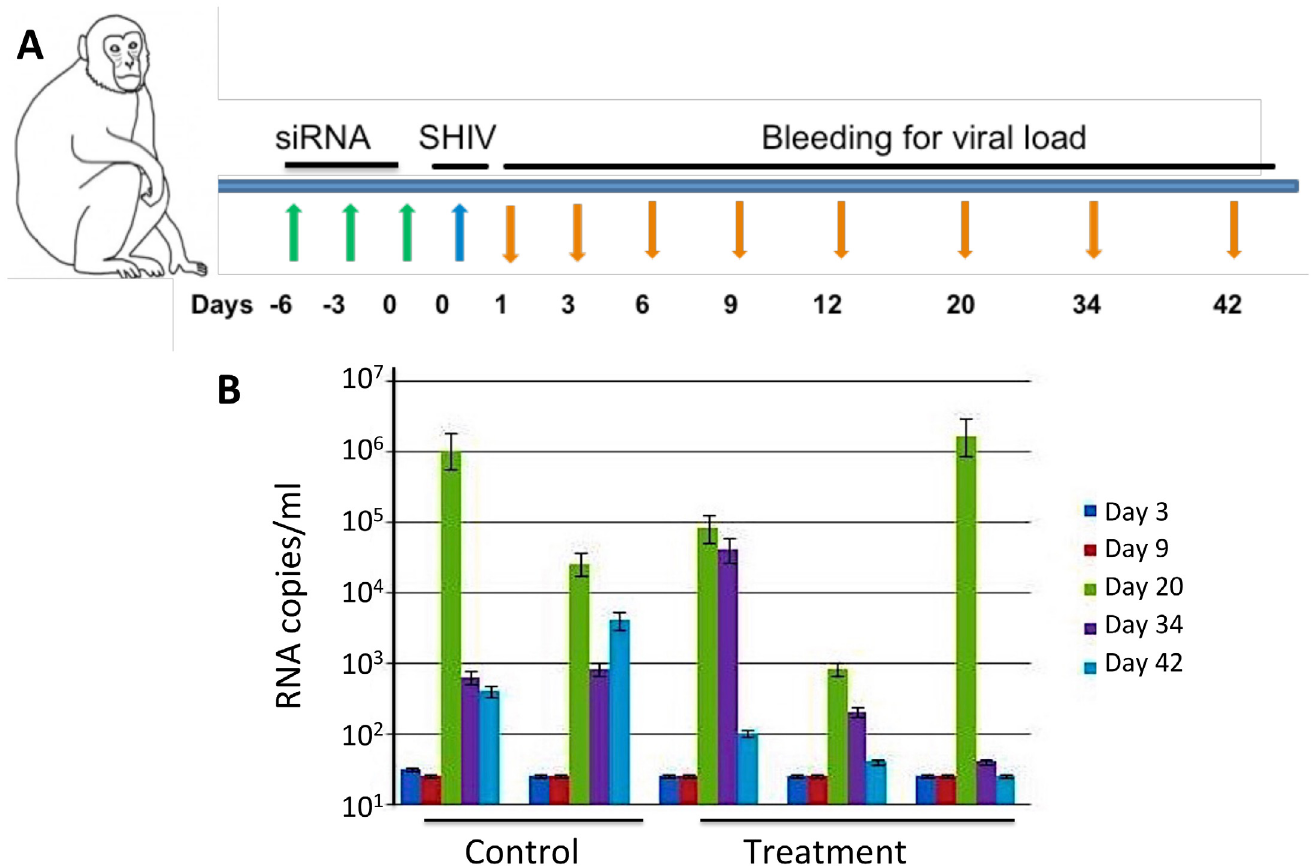
Fig 7. Efficacy of psi cocktail CNs in rhesus monkeys infected with SHIV SF162. (A) Schematic of the protocol used. (B) Treatment of monkeys with a mixture of cream and chlipid nanocomplexes containing plasmid siRNA cocktail resulted in the reduction of viral titers in SHIV SF162 -infected monkeys. Viral RNA was isolated from 200 μ l of the plasma (HighPure viral RNA kit, Roche). Isolated RNA was subjected to reverse transcription and PCR amplification of a region of gag , and the amplified product was quantified by anti-DIG enzyme-linked immunosorbent assay. All the samples were run in